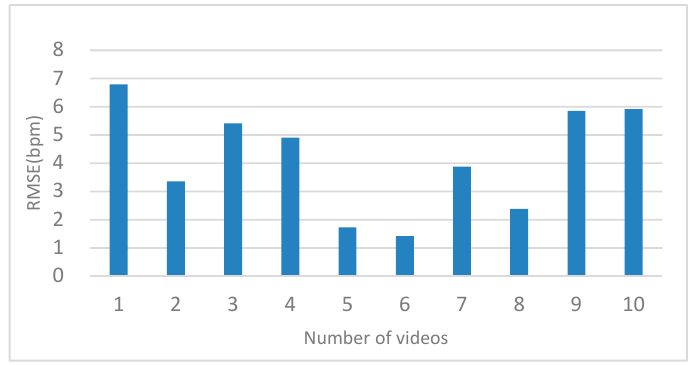
Figure 8. Comparison of the effect of the symmetrical substitution method in the three rectangular regions.